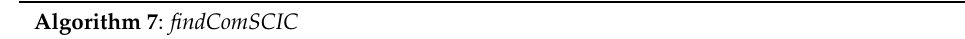
Algorithm 7 : findComSCIC